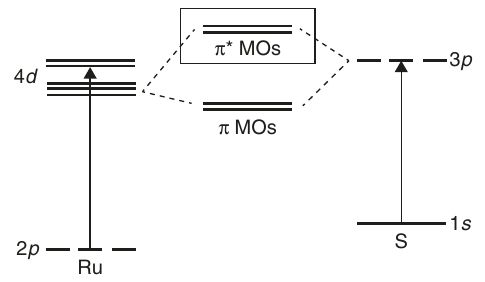
Fig. 2 Relevant atomic orbitals probed by XAS experiments. XAS at the Ru L-edge is characterized by transitions between Ru 2 p orbitals and molecular orbitals containing primarily Ru 4 d character. XAS at the S K-edge is characterized by transitions between S 1 s orbitals and molecular orbitals that are an antibonding combination of S 3 p and Ru 4 d orbitals ( “ π * MOs ” indicated by solid box) and higher-energy ligand-centered